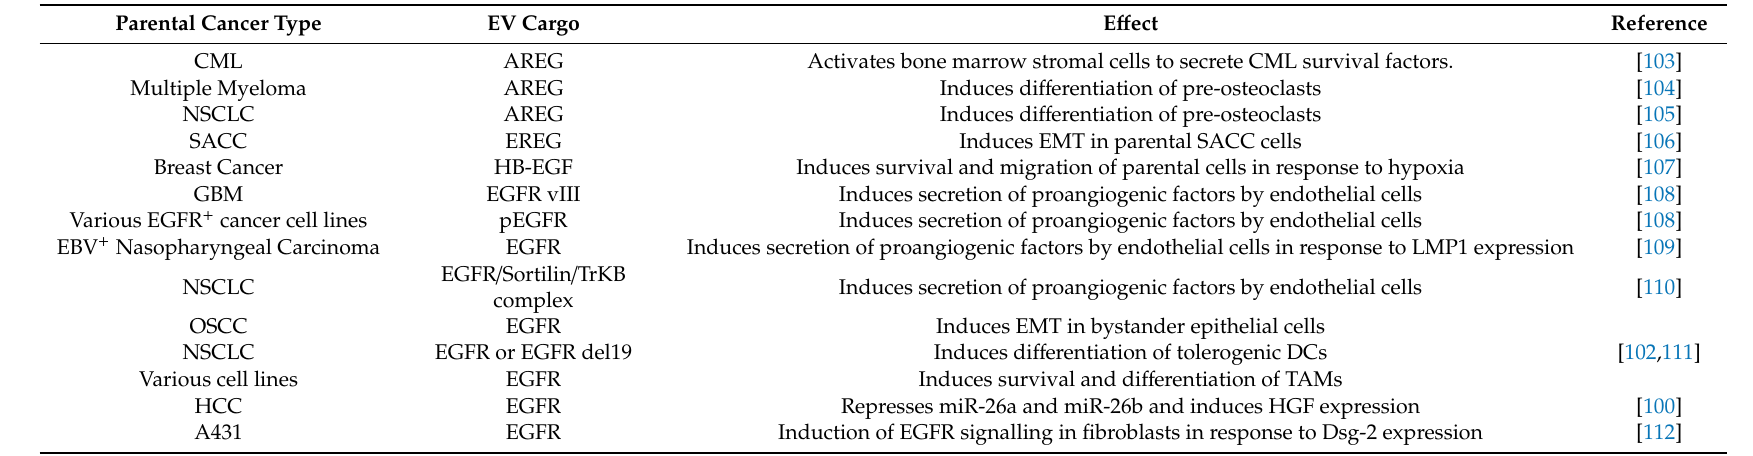
Table 1. Summary of the e ff ects of EGFR and its ligands when packaged in